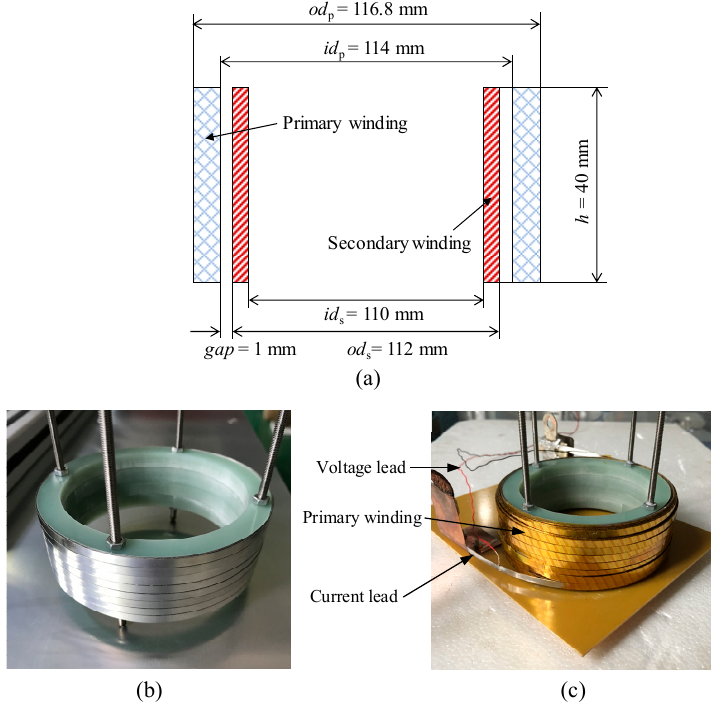
Figure 13. Superconducting inductive SFCL prototype: ( a ) Schematic diagram, ( b ) secondary winding, ( c ) SFCL prototype.